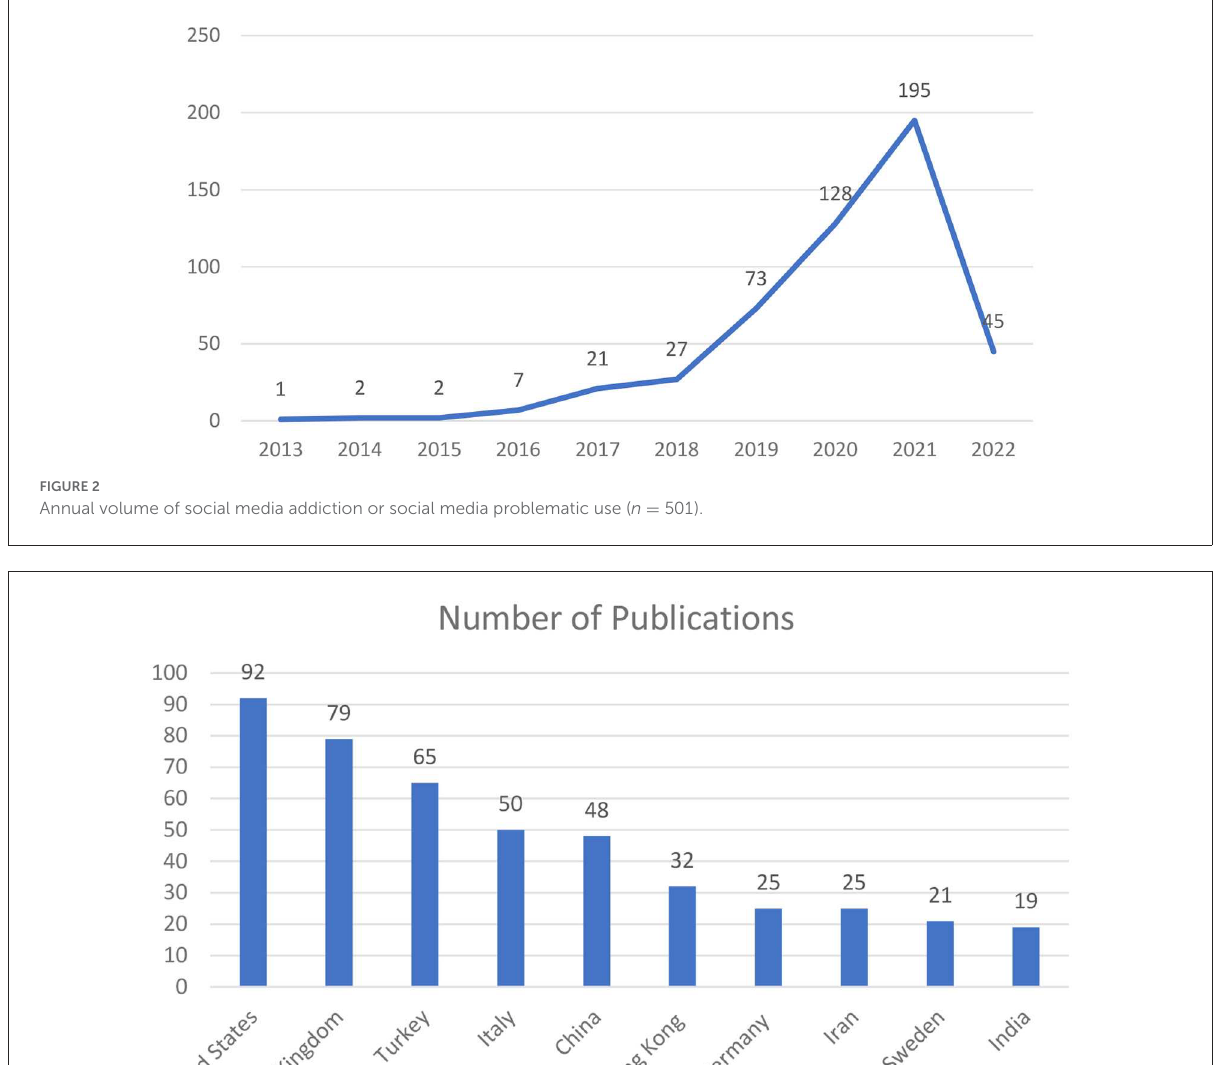
peak was reached in 2021 with 195 publications.